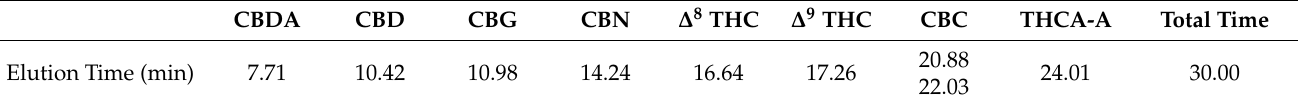
Figure 6. Ten-cannabinoid mixture separation under reversed-phase conditions with Chiralpak ID- U+IC-U. Table 7. Elution times for 10-cannabinoid reversed-phase separation on Chiralpak ID-U+IC-U.